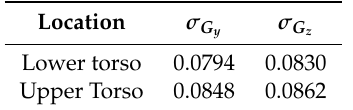
Figure 3. Location of sensors for training and validation. Table 1. Differences in sensed data at 60 steps per minute in lower and upper torso